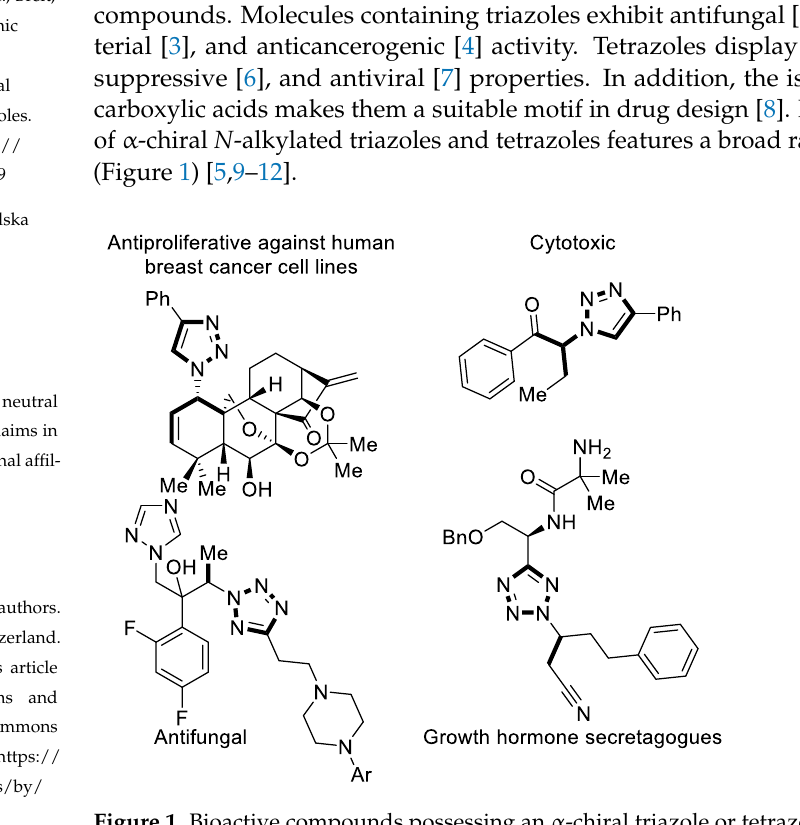
Figure 1. Bioactive compounds possessing an α -chiral triazole or tetrazole scaffold [5,9 – 11].